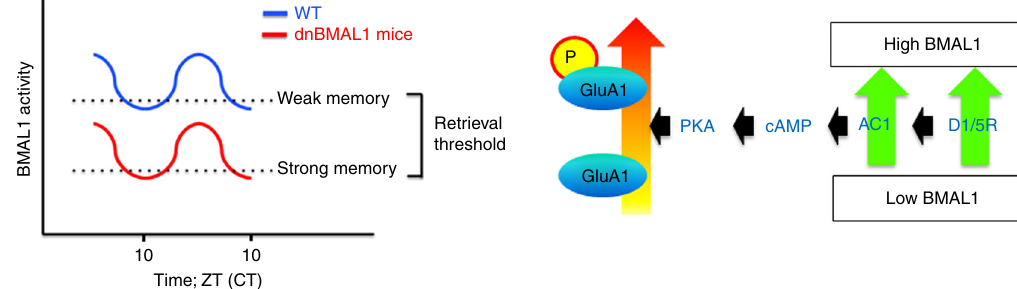
Fig. 7 Model of circadian regulation of memory retrieval. Both WT and dnBMAL1 mice show a time-of-day retrieval pro fi le. However, dnBMAL1 mice show worse retrieval performance at any time compared to WT mice; dnBMAL1 mice show impairments in retrieval of weak and strong memories at ZT4 and ZT10, respectively, compared to WT mice. Phosphorylation of GluA1 at S845 is required for maintenance of